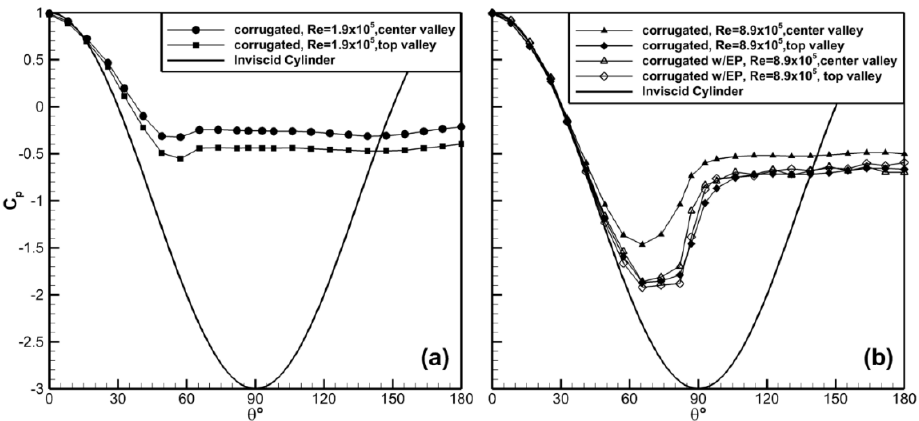
Figure 13. Comparison of pressure distribution in the center and top channels. ( a ) Re = 1.9 × 10 5 , ( b ) Re = 7.7 × 10 5 .